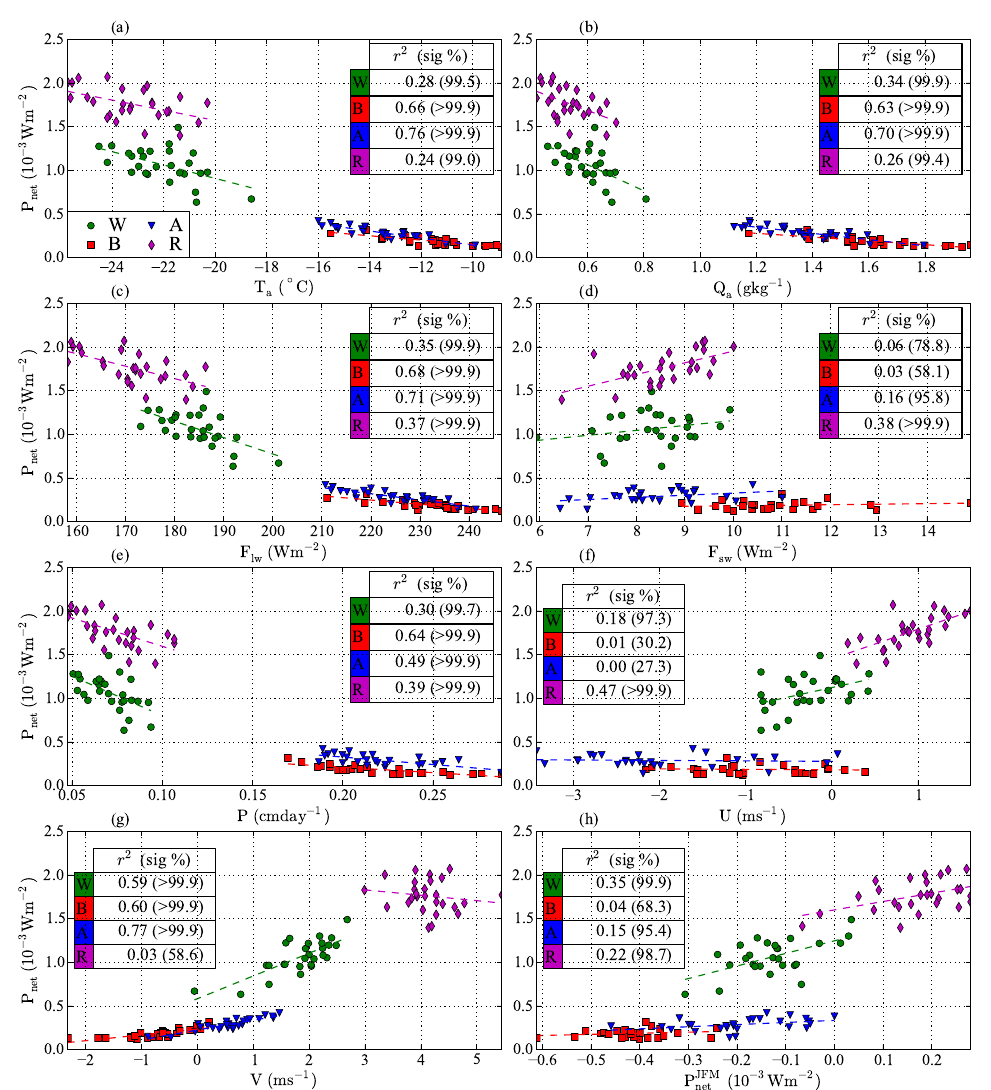
Fig. 15. Linear temporal correlation of the spatial (shelf sea) mean autumn/winter (April–September) net surface power input to the mixed layer against the spatial mean autumn/winter: (a) 2m air temperature, (b) 2m specific humidity, (c) incoming long-wave radiation, (d) incom- ing short-wave radiation, (e) total precipitation (rain and snow), (f) 10m zonal wind speed, (g) 10m meridional wind speed and (h) summer net surface power input, for the grid points representing each region shown in Fig. 11. Each coloured data point represents a shelf sea and corresponds to the shelf sea annual value. The linear regression lines of each shelf sea data set are shown by the dashed lines, with the coefficient of determination ( r 2 ) and significance of the correlation shown in the tables within each